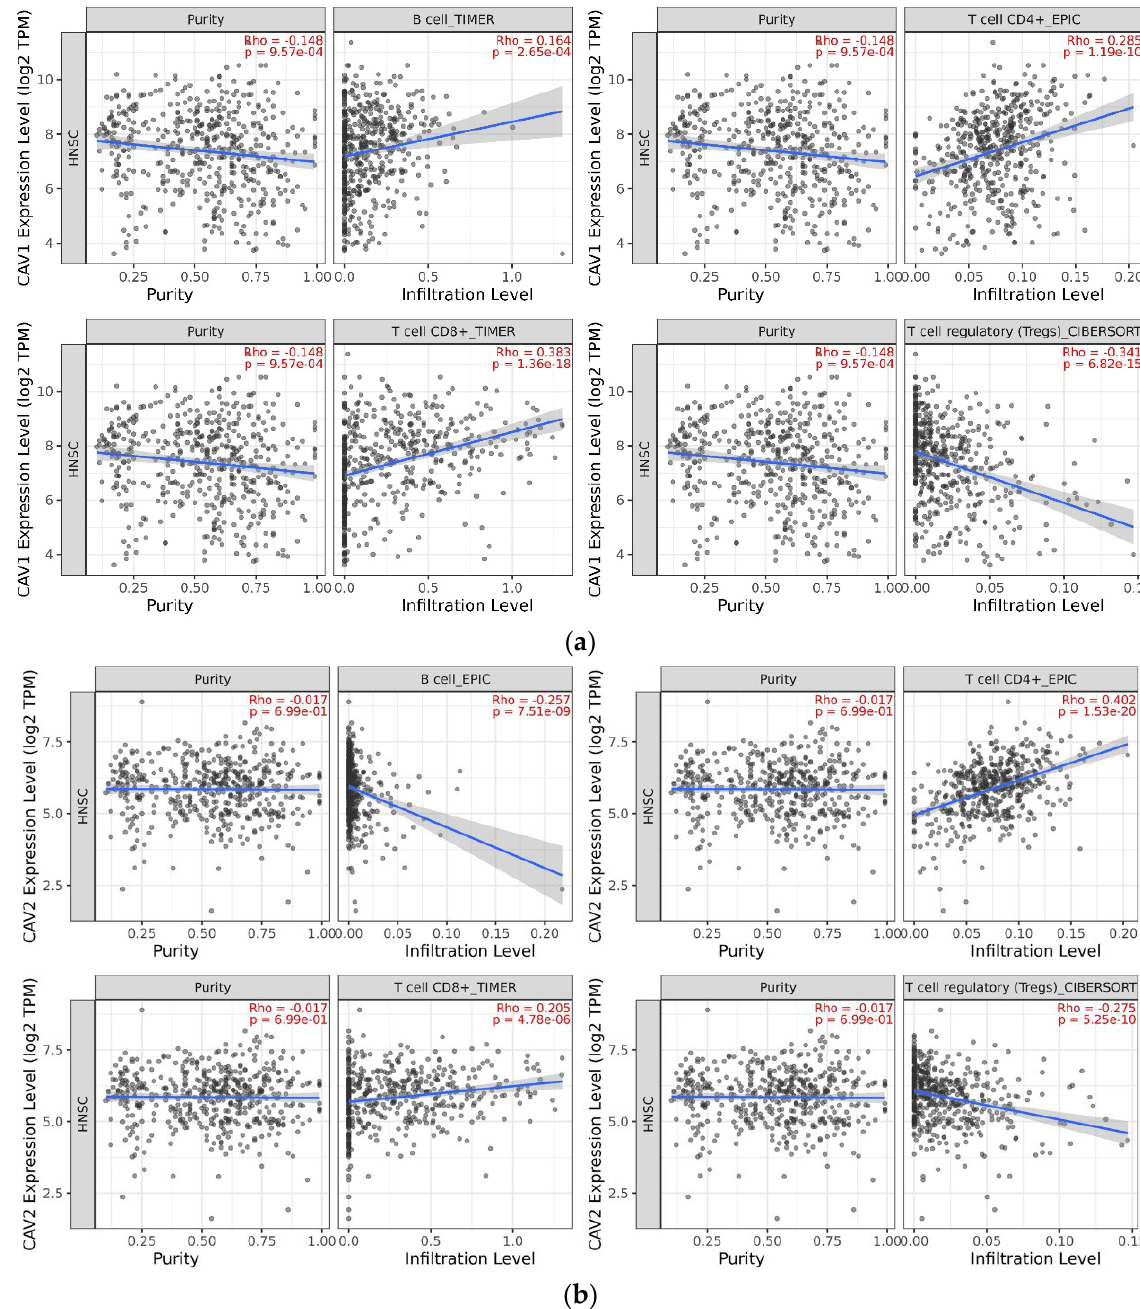
Figure 9. Higher expression of CAV1 is related to the downregulation of Tregs cells but shows the opposite result in CD8 + T cell, CD4 + T cell, and B cell. ( a ) Higher expression of CAV2 is related to the decrease in immune infiltration of Tregs cell and B cell and demonstrates an upregulation effect on CD8 + T cell and CD4 + T cell ( b ) in the